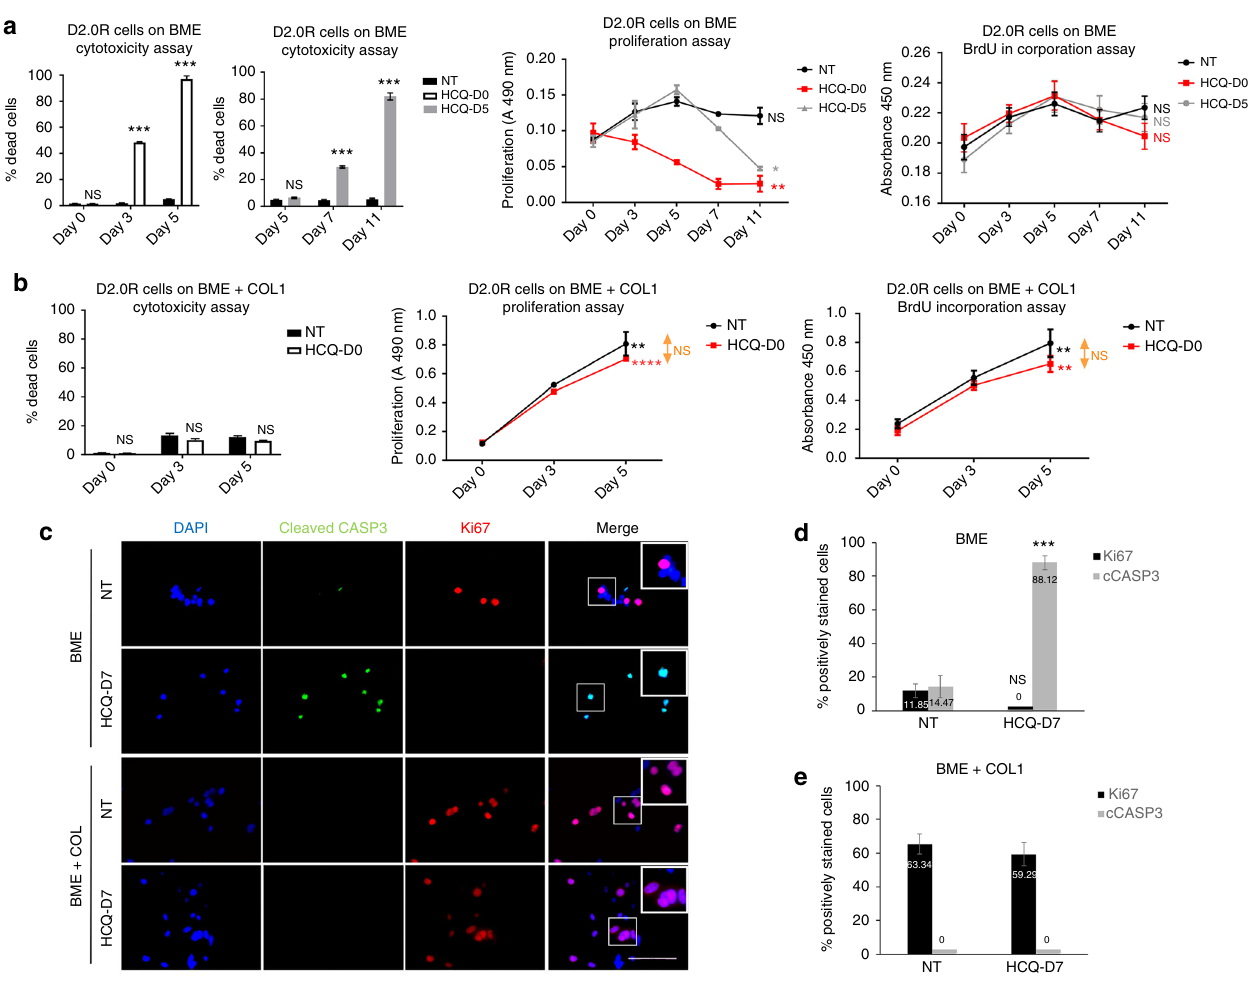
Fig. 2 Inhibiting autophagy reduces the viability of D2.0 R dormant cells. Figure shows data of one out of three independent experiments done in triplicate with equivalent results for each assay. a 50 µ M Hydroxycholoroquine (HCQ) induced a signi fi cant reduction in the proportion of viable D2.0R cells on BME, as determined by cytotoxicity assay (mean± s.e.m, n = 3 wells. Comparisons by unpaired two-sided T -test. *** P ≤ 0.0001), proliferation assay (mean ± s.e.m, n = 3 wells. Comparisons at day 11 by unpaired two-sided T -test. * P ≤ 0.05 and ** P ≤ 0.01 relative to Day 0 for each group) and BrdU incorporation assay (mean ± s.e.m, n = 3 wells. Comparisons at Day 5 by unpaired two-sided T -test relative to Day 0 for each group) regardless of whether the treatment was or was not delayed after seeding the cells. b HCQ did not affect the numbers of viable D2.0 R cells on BME + COL, as determined by a cytotoxicity assay (mean ± s.e.m, n = 3 wells. Comparisons by unpaired two-sided T -test), proliferation assay (mean ± s.e.m, n = 3 wells. Comparison Day 11 vs. Day 0 by unpaired two-sided T -test. ** P ≤ 0.01 and **** P ≤ 0.0001) and BrdU incorporation assay (mean ± s.e.m, n = 3 wells. Comparisons at Day 5 by unpaired two-sided T -test. ** P ≤ 0.01 relative to Day 0 for each group). c Representative Ki67 (red) and cleaved caspase 3 (green) immuno fl uorescence of D2.0R cells on BME (upper panels) and D2.0 R cells on BME + COL (lower panels), either treated with 50 µ M HCQ or vehicle. Scale bar is 100 μ m. Proliferative and apoptotic indexes of D2.0 R on BME or BME plus COL1 were calculated as the percentage of cells expressing Ki67 or cleaved Casp 3, as shown in d for cells on BME (mean ± s.e.m, n = 159 – 173 cells. Comparison by Mann – Whitney U -test, two-sided. *** P ≤ 0.0001) and e for cells on BME + COL1 (mean ± s.e.m, n = 167 – 257 cells. Comparison by Mann – Whitney U -test, two-sided), respectively. HCQ-D0 cells treated with HCQ immediately after plating on Day 0, HCQ-D5 cells treated with HCQ after 5 days in culture, HCQ-D7 cells treated with HCQ after 7 days in culture, NT